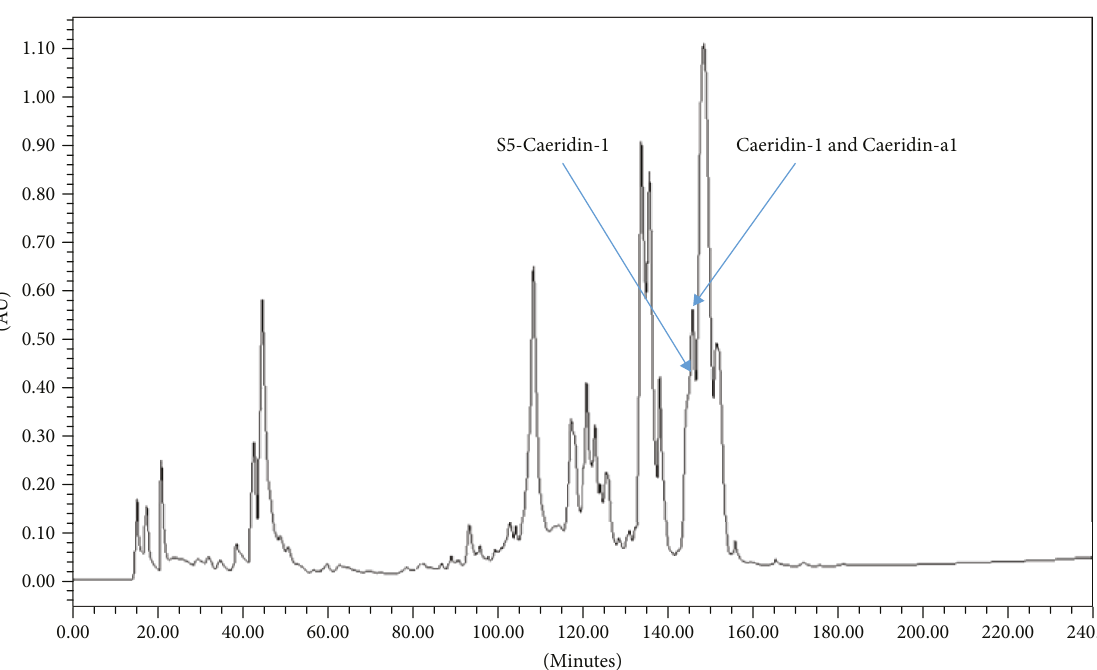
Figure 4: Reversed-phase high-performance liquid chromatography (HPLC) chromatogram of the skin secretion from L. caerulea . Caeridin- 1, S5-Caeridin-1, and Caeridin-a1 were eluted at approximately 144min, 143min, and 144min, respectively. The y -axis shows the relative absorbance in absorbance units (AU) at a wavelength of 214 nm, and the x -axis shows the retention time in